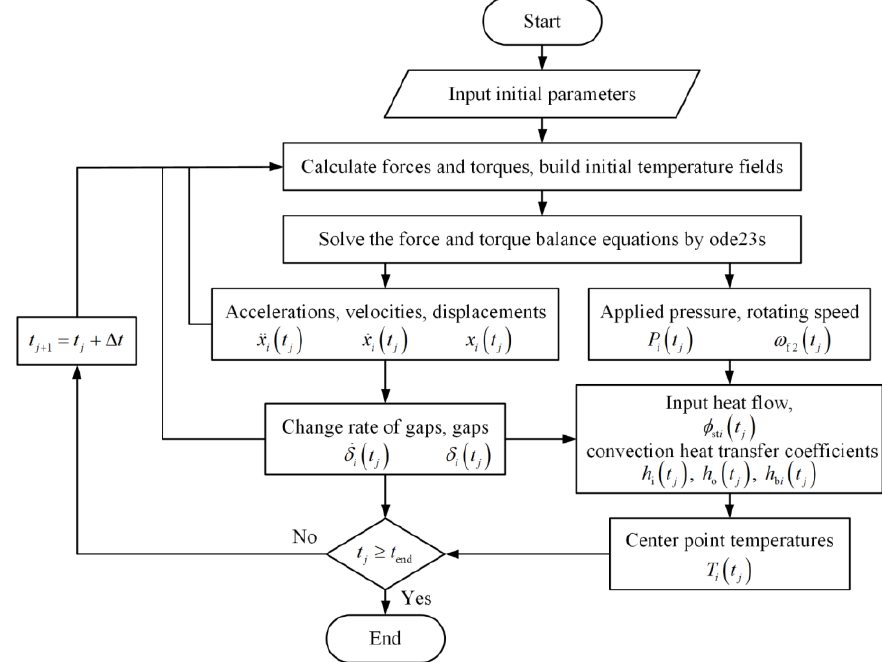
Figure 3. Flow chart of the simulation.